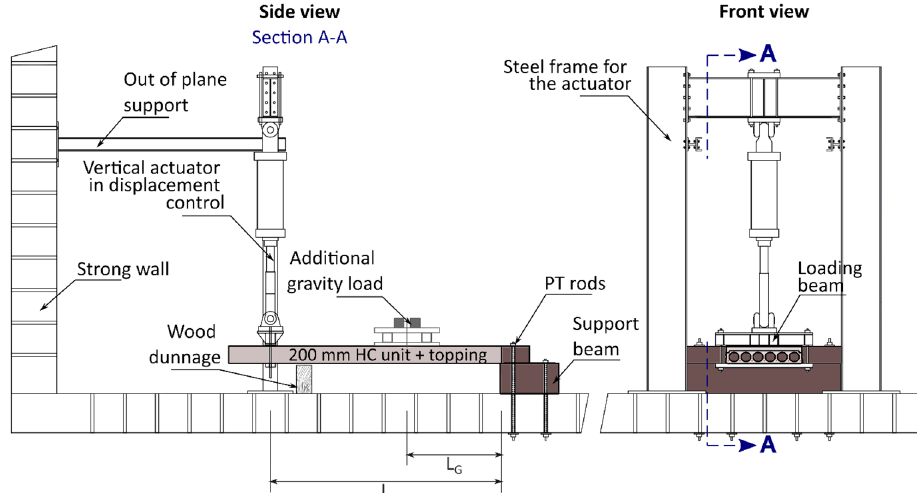
Fig. 6 Sub-assembly experimental test